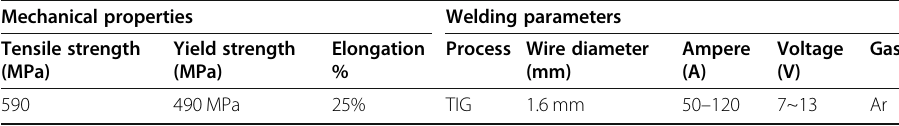
Table 2 Mechanical properties and welding parameters Mechanical properties Welding parameters